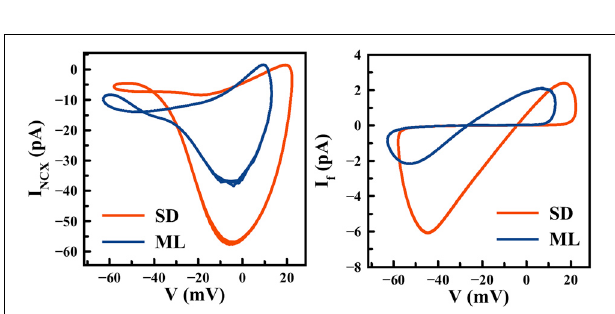
FIGURE 9 | Differences in I NCX (left) and I f (right) between the ML and SD model. Computer simulations are performed over a number of pacemaking cycles using default parameter